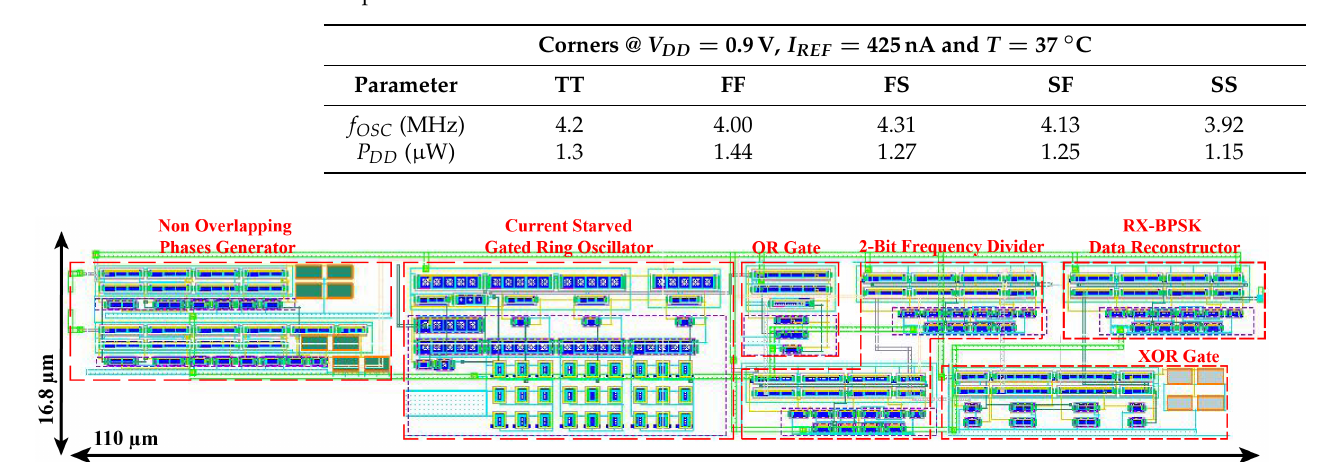
Table 5. Current Starved Gated Ring-Oscillator (CSGRO): post-layout corner simulations at body temperature.